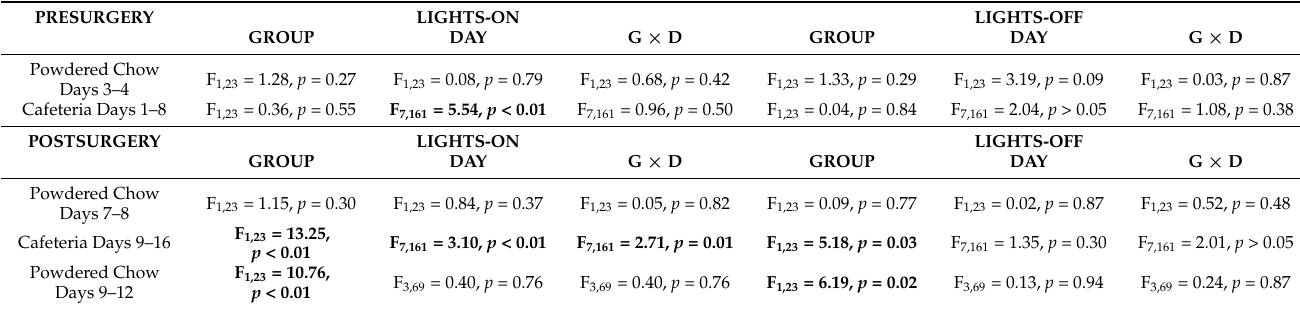
Table 16. Two-way ANOVAs Comparing Meal Number for Lights-On and Lights-Off Meals between Groups for Each Diet Condition.